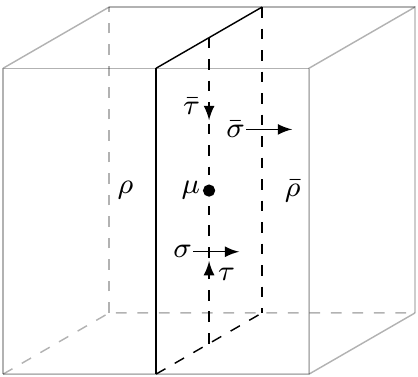
Figure 6: Cell decomposition for a 3D lattice respecting inversion symmetry with inversion center µ . Cell ¯ s and cell s are related by (magnetic) inversion symmetry (cid:101) I : ¯ s = (cid:101) I ◦ s . Orientations for 1-cells and 2-cells are denoted by arrows, while 3-cells ρ ◦ ρ have opposite and ¯ ρ = (cid:101) I